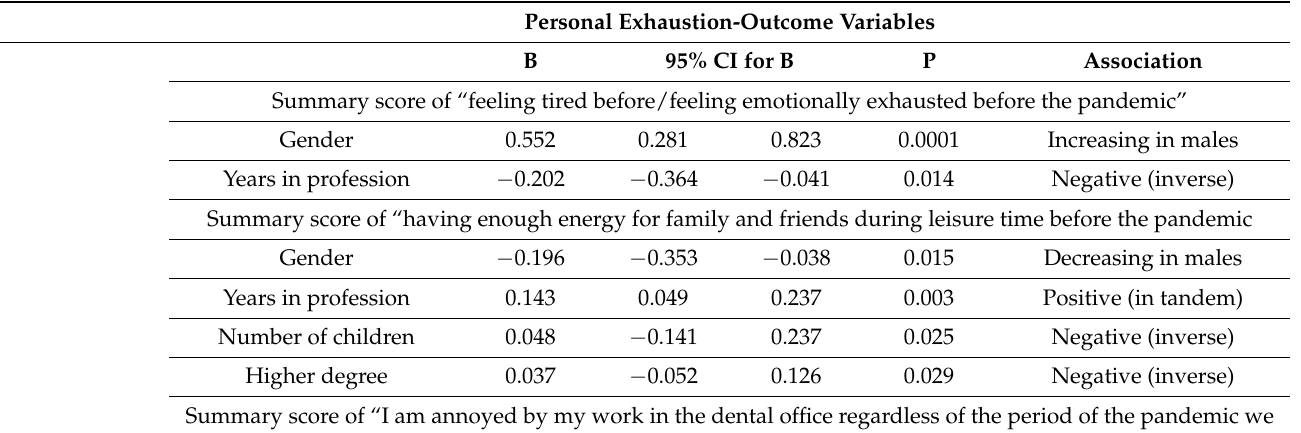
Table 2. Personal exhaustion before and during pandemic (multiple linear regression